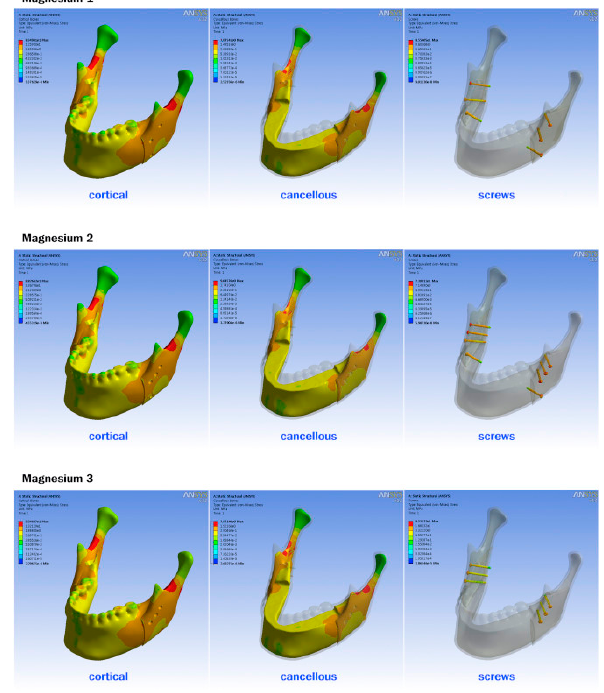
Figure 5. The distribution of stress in magnesium alloy screws according to different screw configurations: 1—triangular, 2—reinforced triangular, 3—linear. Reproduced with permission from [75], Elsevier, 2017.